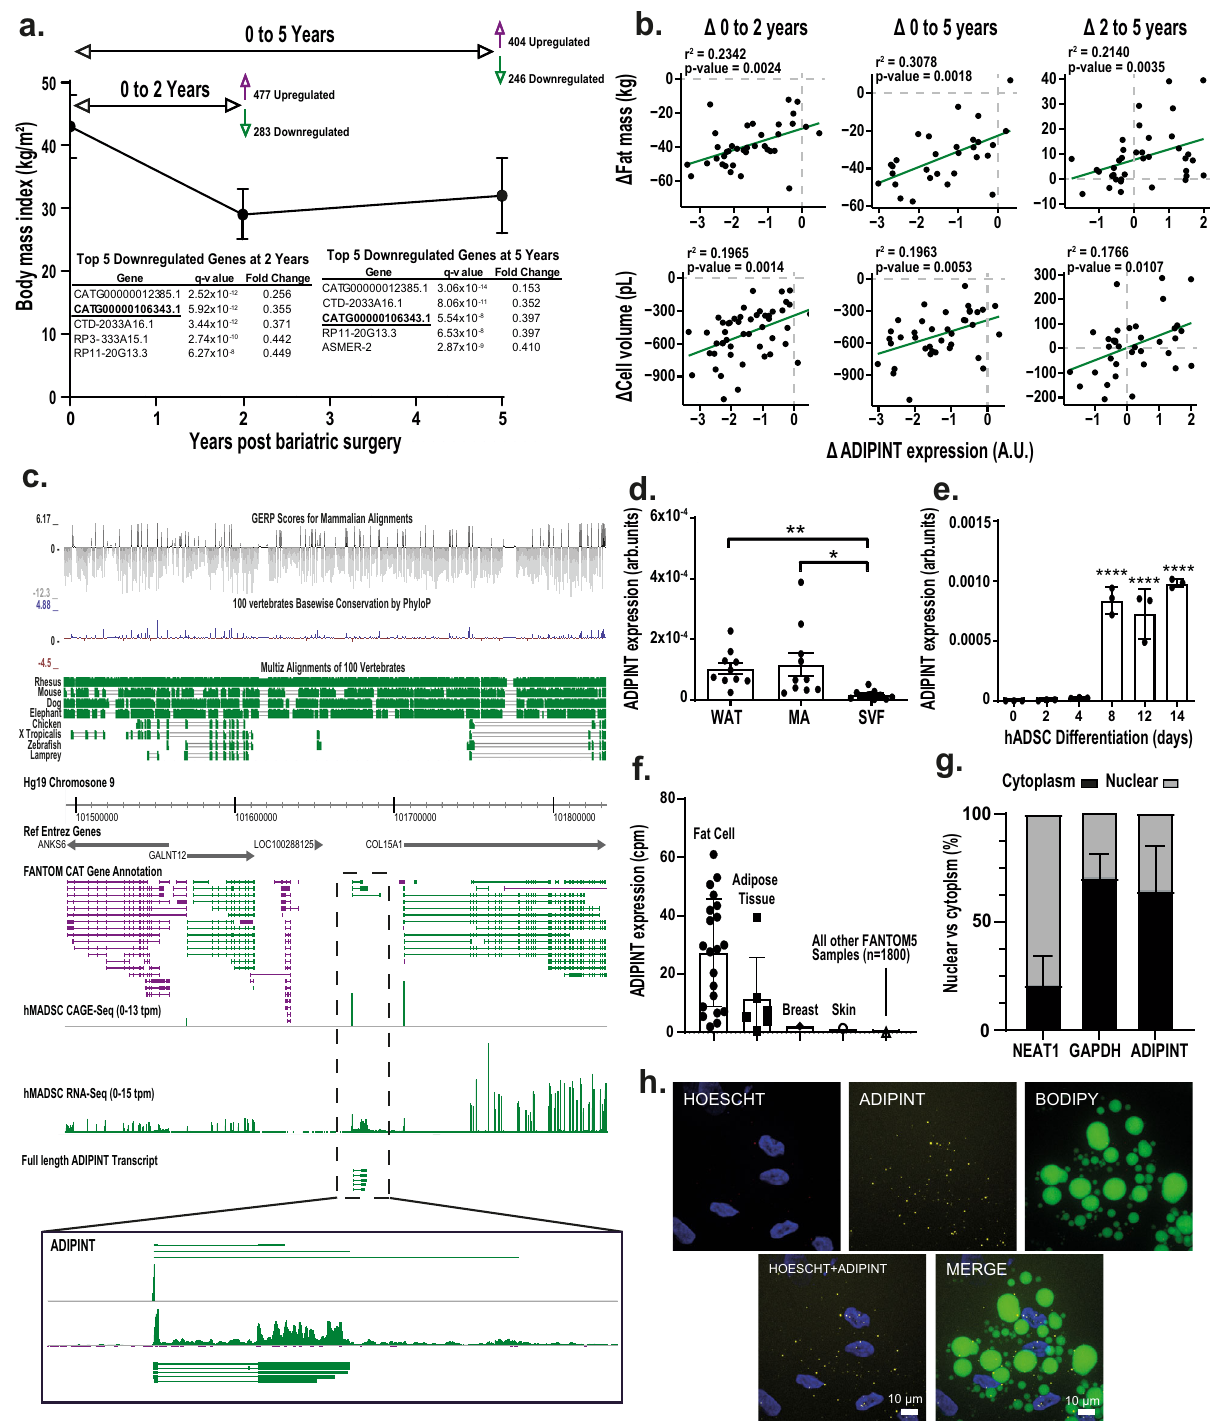
of the 38 dysregulated proteins (marked by an asterisk in Fig. 2l) were not signi fi cantly regulated at the transcript level, indicating post-transcriptional regulation. Pathway analysis of the 38 dysregu- lated proteins showed overrepresentation for the GO terms mitochondrial matrix and fatty acid metabolic process (Supplemen- tary Data 10 – 11) in line with the changes observed above in lipid and energy metabolism. Based on the information at www.genecards.org, we visualized all 38 proteins affected after ADIPINT knockdown in Fig. 2k. Most proteins were downregulated and involved in fatty acid synthesis and oxidation. Proteins within the pyruvate dehydrogenase